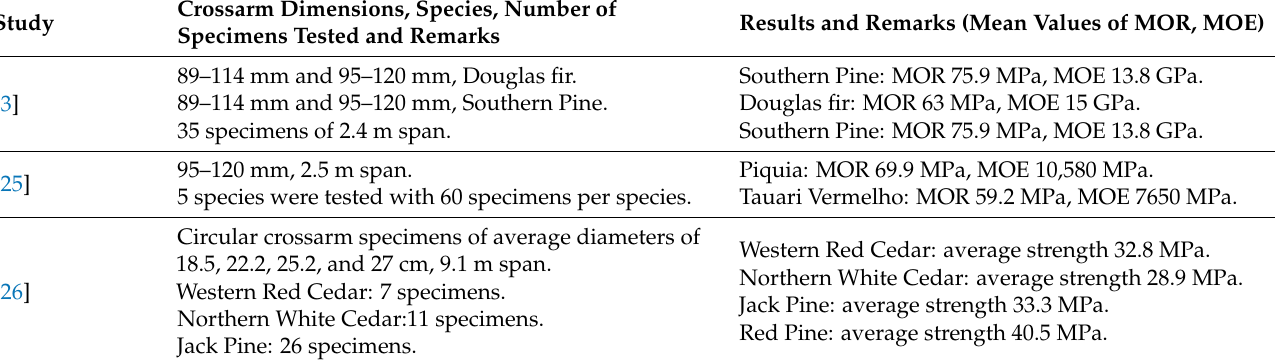
Table 2. Studies that examined the flexural strength of timber